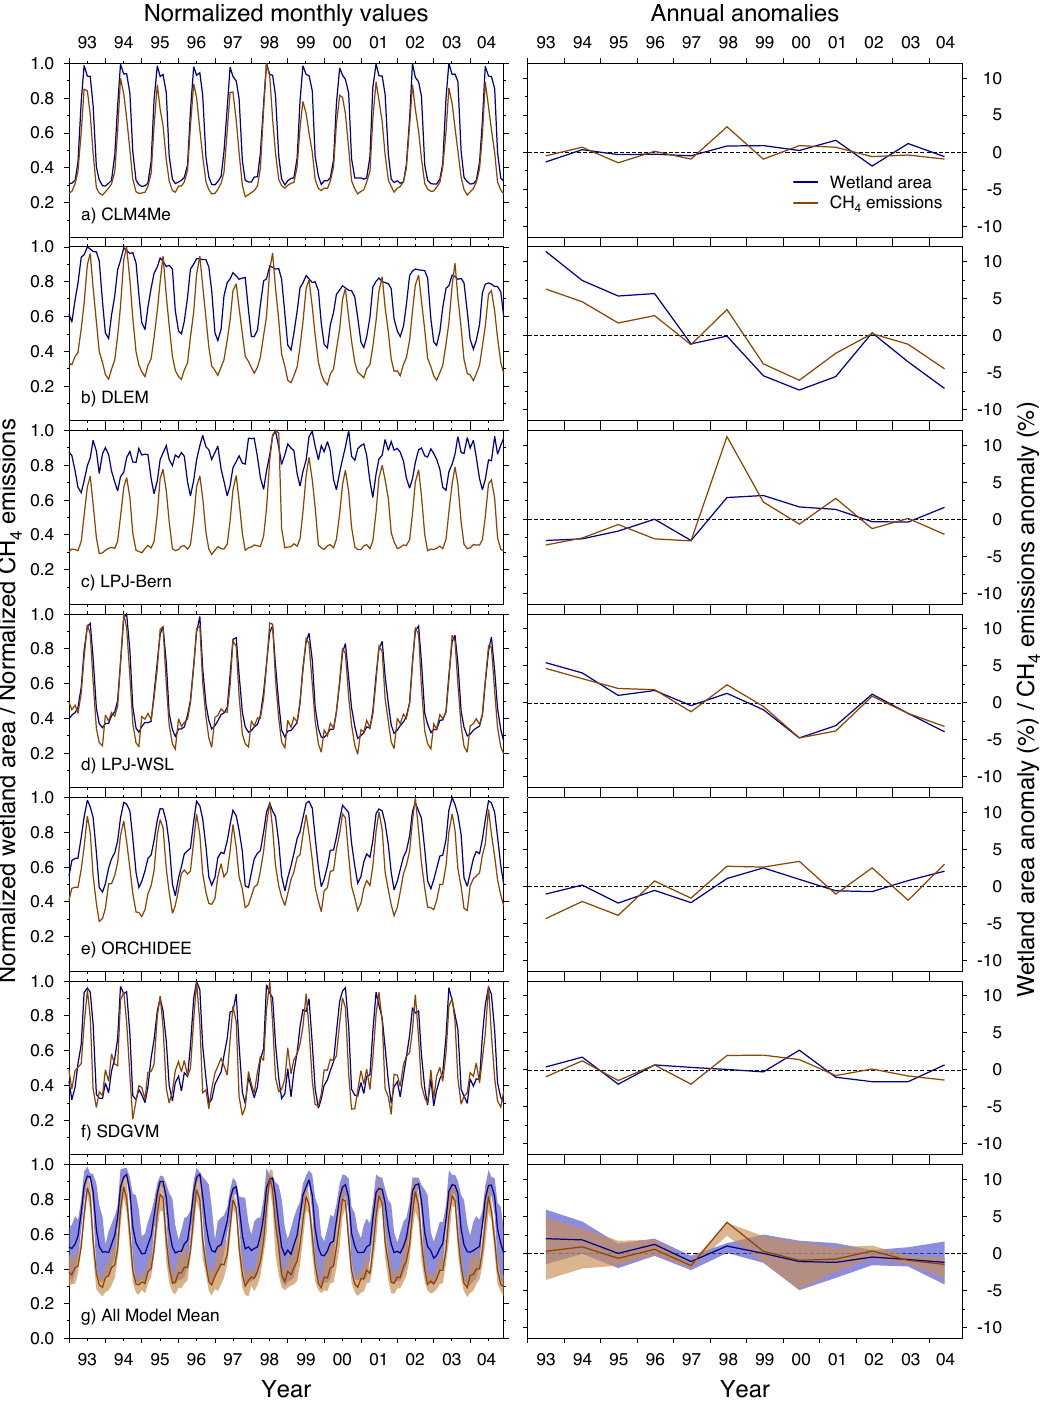
Fig. 7. Global normalized monthly wetland area and CH 4 emissions (left column) and global annual CH 4 emissions and wetland area percent anomalies (right column) for 1993–2004. The Spearman correlation coefficients are listed in Table 4. Anomalies are calculated relative to the maximal value of 1993–2004 for each model, where the maximal value is set to 1 and the other values scale between 0 and 1. The model mean value includes all models. Shading indicates the models’ 25th and 75th percentile